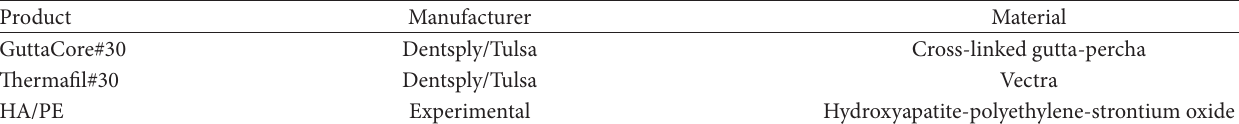
Table 1: Endodontic obturators used in this study.